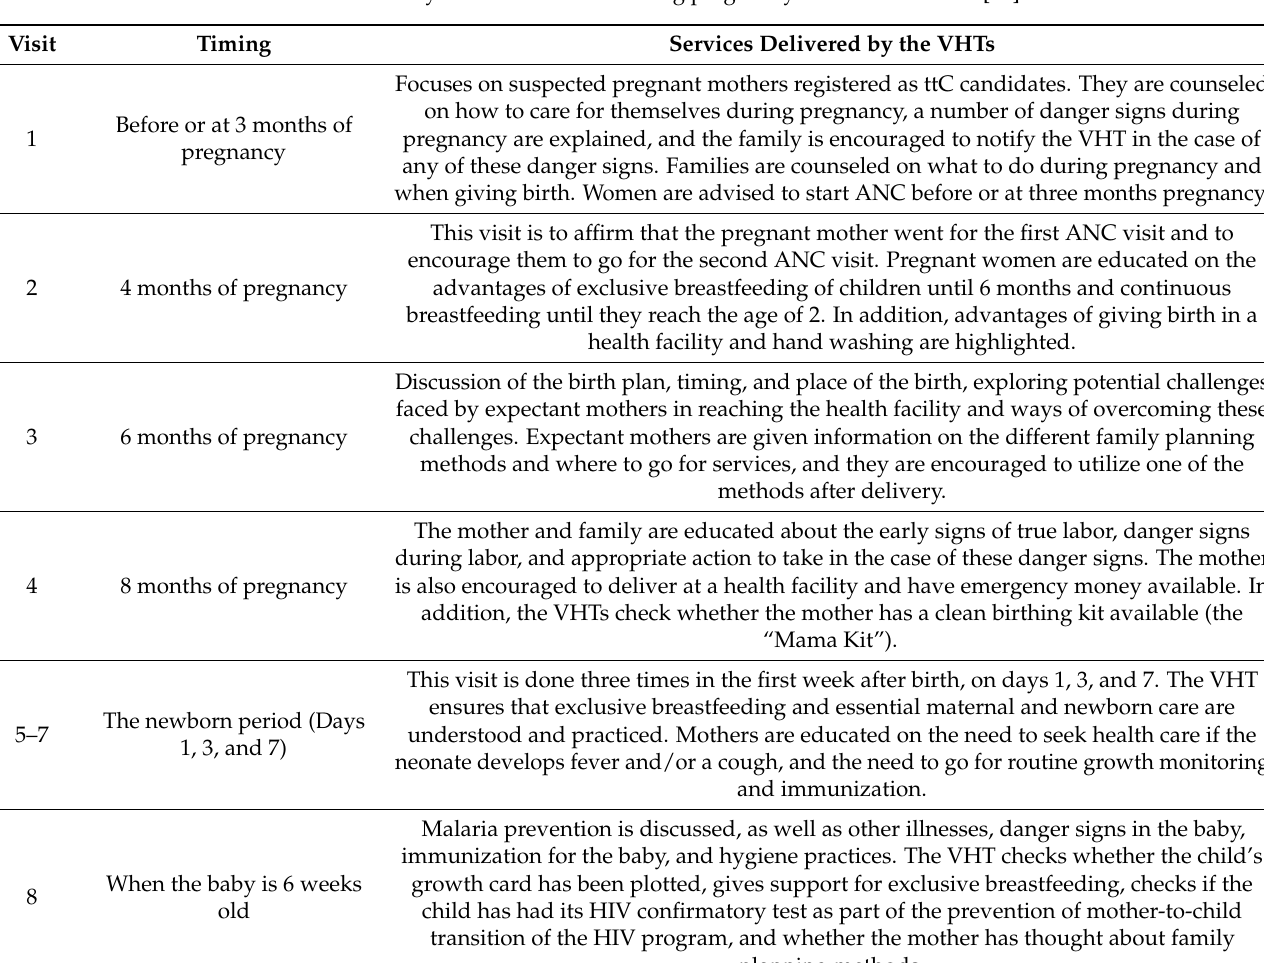
Table 1. ttC visits by VHTs to mothers during pregnancy or after childbirth